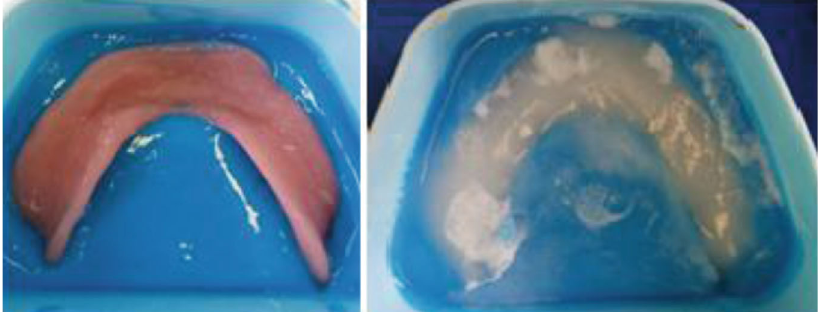
Figure 19: Prosthesis